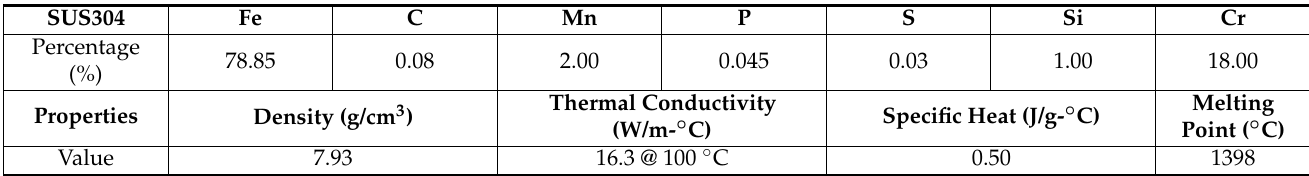
Table 2. 304 stainless steel material properties.